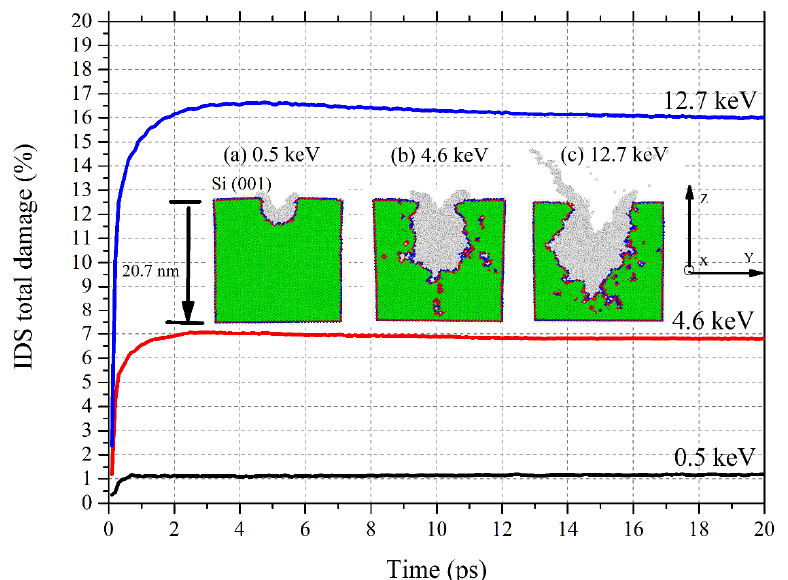
Figure 7. Identify diamond structure ( IDS) total damage to the silicon target as a function of time during ( a ) 0.5 keV, ( b ) 4.6 keV, and ( c ) 12.7 keV Si 35 cluster implantation. The insets represent the cross-sectional view of IDS damage in the target at 10 ps. The green dots represent silicon atoms, the red dots represent the first neighbor silicon atoms, the blue dots represent the second neighbor silicon atoms, and the gray dots represent amorphous atoms.